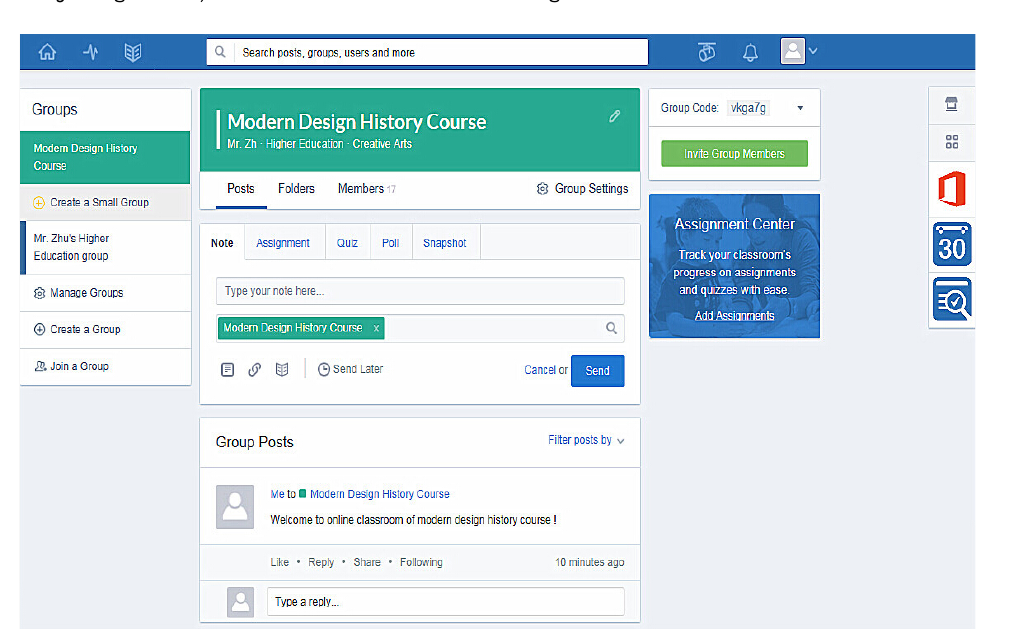
Figure 2. The online interactive interface of the course on Edmodo